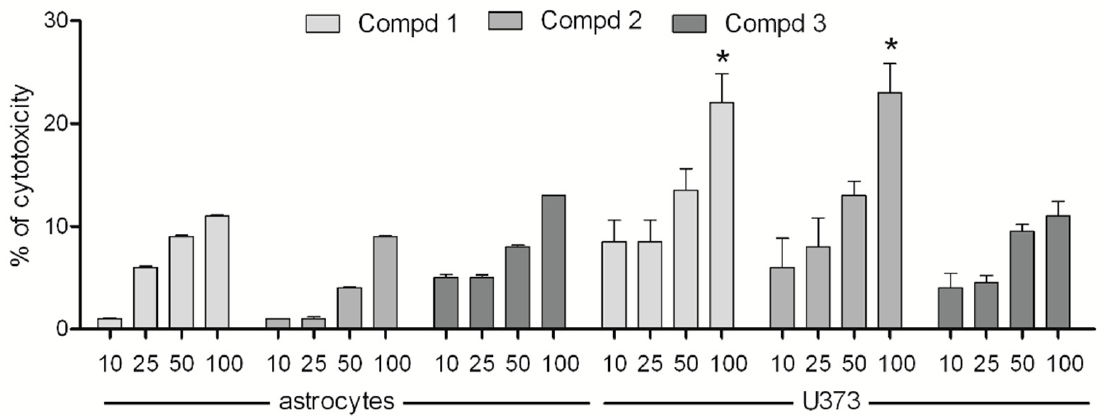
Figure 2. Effect of compounds 1 , 2 , and 3 on viability of astrocytes ( a ) and human glioma cells ( b ). Cells were cultured in medium supplemented with 10% FBS and antibiotics in the presence or absence (control) of compounds (10, 25, 50, or 100 µM). After 24 h incubation, the MTT assay was performed. Doxorubicin (DOX) was used as a positive control. Results from the MTT assay are presented as percent of living cells compared to the control. Values represent means ± SEM of three independent experiments ( p < 0.05).